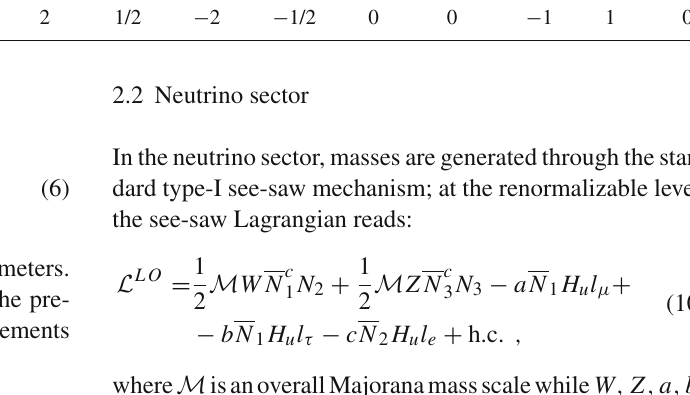
Table 1 U ( 1 ) F charges for leptons, Higgses and flavon fields l